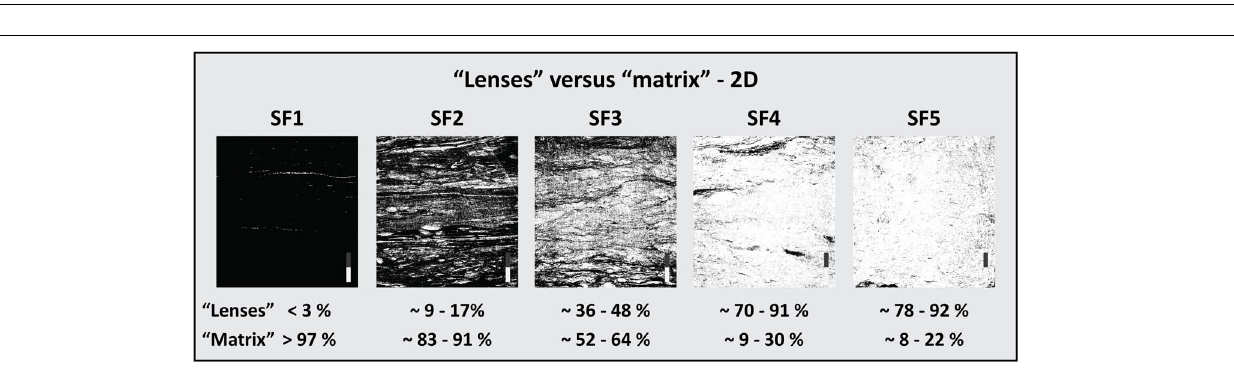
FIGURE 8 | Mineralogical composition at Mont Terri and northern Switzerland by major sub-unit. Mont Terri: shaly 1, lower shaly facies; carb.-rich, carbonate rich sandy facies; sandy 1, lower sandy facies; shaly 2, upper shaly facies; sandy 2, upper sandy facies. ∗ , data from Huber (2018), in wt%. ∗∗ , data from Lerouge et al. (2015), in wt%. ∗∗∗ , data from Waber and Rufer (2017), in wt%. Northern Switzerland: clay-rich, «clay-rich sub-unit«; carb.-rich, «carbonate-rich silty sub-unit«; mix. c-s-c, «mixed clay-silt-carbonate sub-unit«; silty, «upper silty sub-unit«; s-c beds, «sub-unit with silty calcareous beds« (sub-unit classification according to Mazurek and Aschwanden, 2020). Data for northern Switzerland are compiled and referenced in Mazurek (2017). Carbonates include calcite, dolomite, ankerite and siderite; quartz includes minor feldspars; clay minerals are not distinguished. They include kaolinite, illite, illite-smectite mixed layers, chlorite, as well as muscovite. Sum contents of the three mineral groups (carbonates, quartz, and clay minerals) are normalized to 100%; further minor components are not considered.